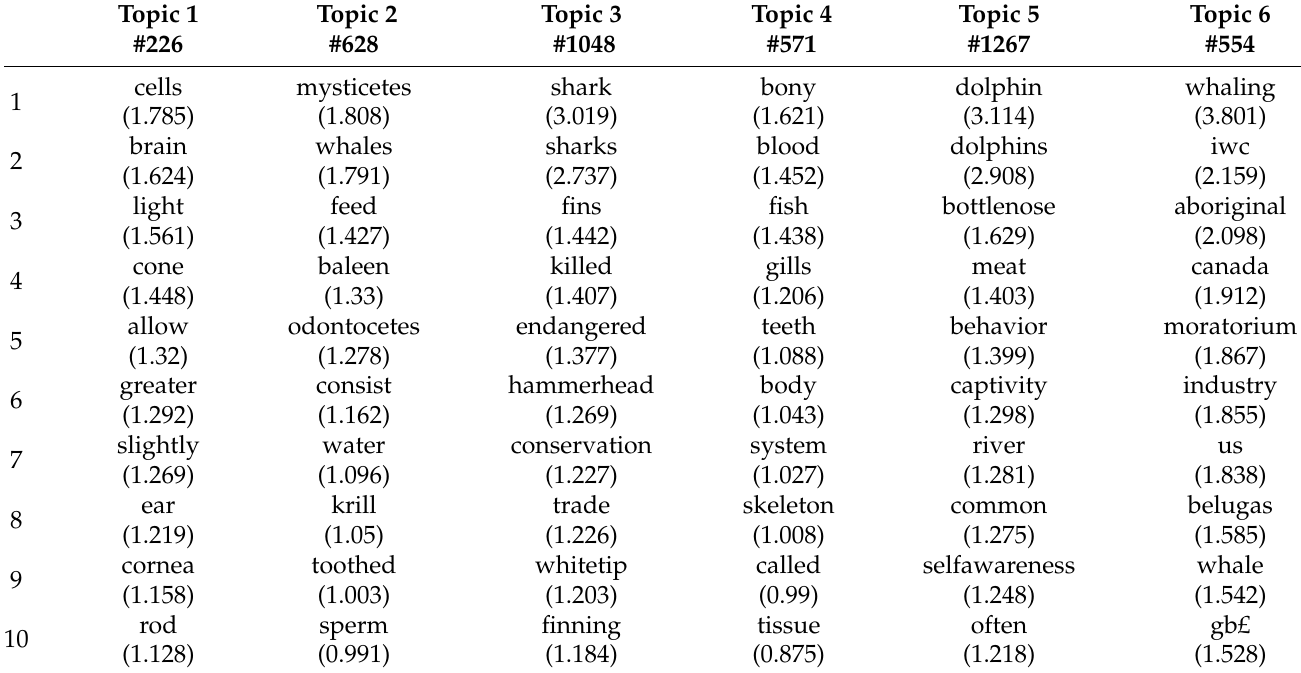
Table A6. Each column lists the top 10 representative words per dimension of the basis matrix A .